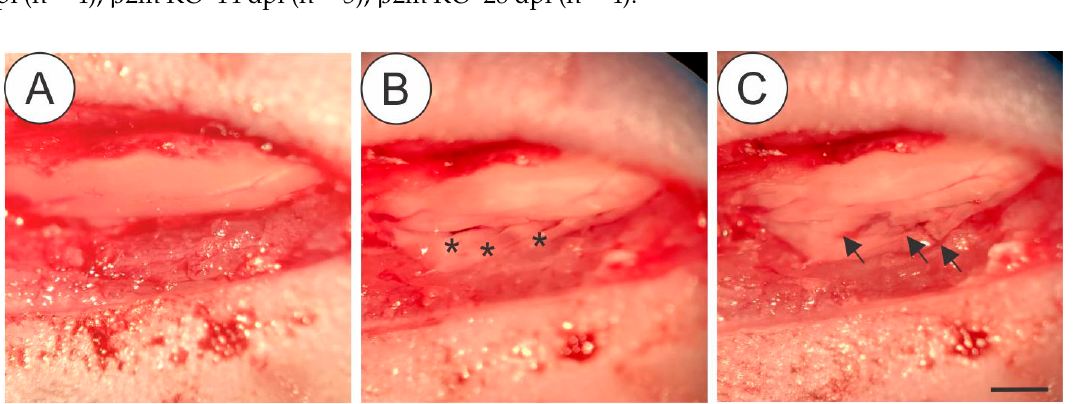
Figure 1. Details of the surgical procedure for ventral root crush in mice showing the exposed spinal cord with intact dura-mater after laminectomy ( A ), the L4, L5 and L5 ventral roots (asterisk) isolated after dura-mater longitudinal incision ( B ) Crushed roots ( C - arrows), where it is possible to depict the persistence of the connective tissue at the injury site. Scale bar = 1 mm.